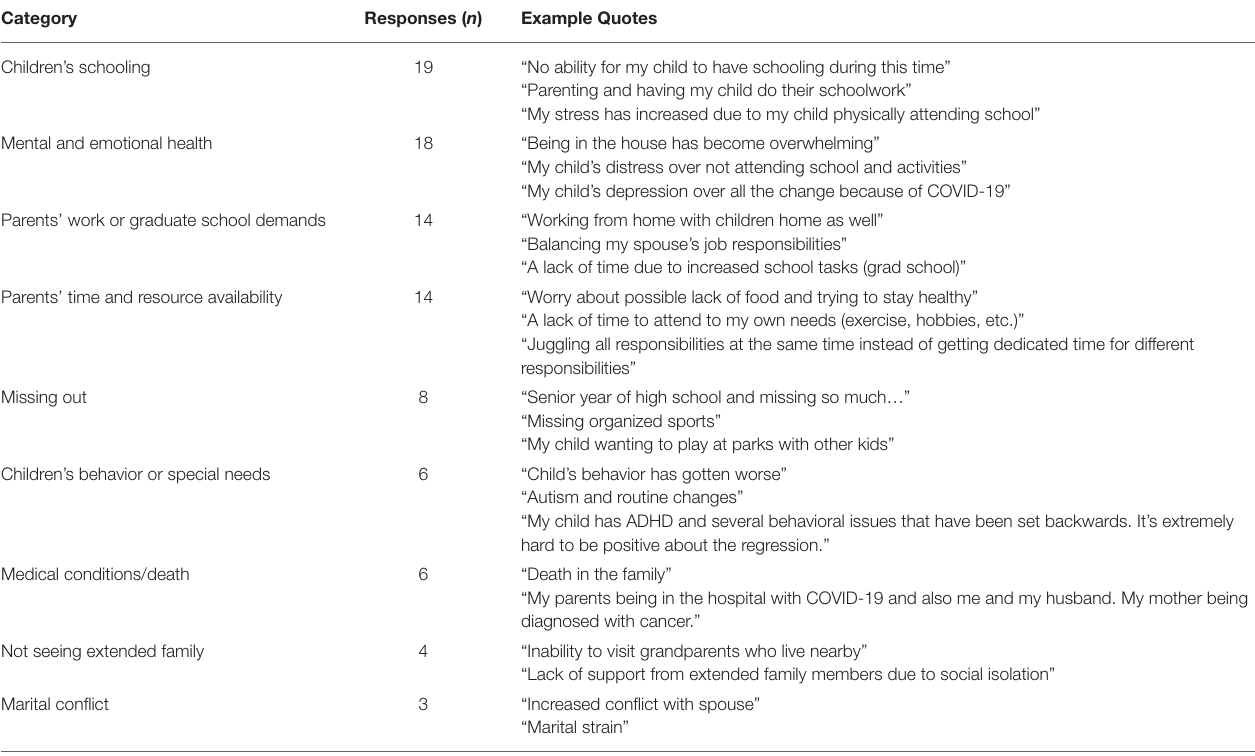
TABLE 2 | Parent “other” responses to factors influencing parenting difficulties during the COVID-19 pandemic, categorized by